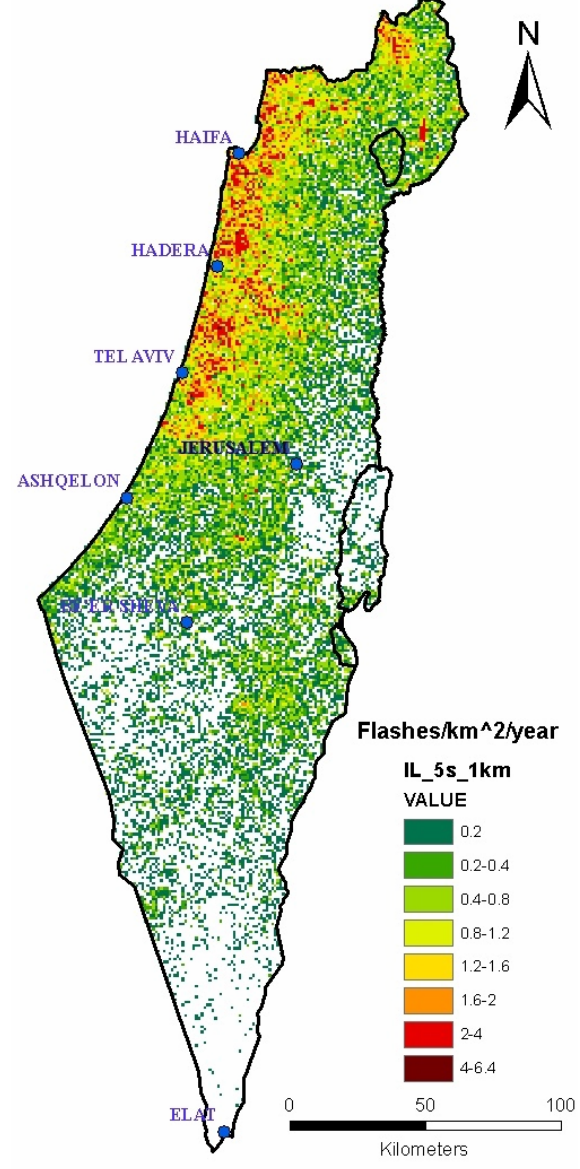
Fig. 6. Spatial distribution of flash density per 1km 2 yr − 1 over Israel, based on cell size of 1km 2